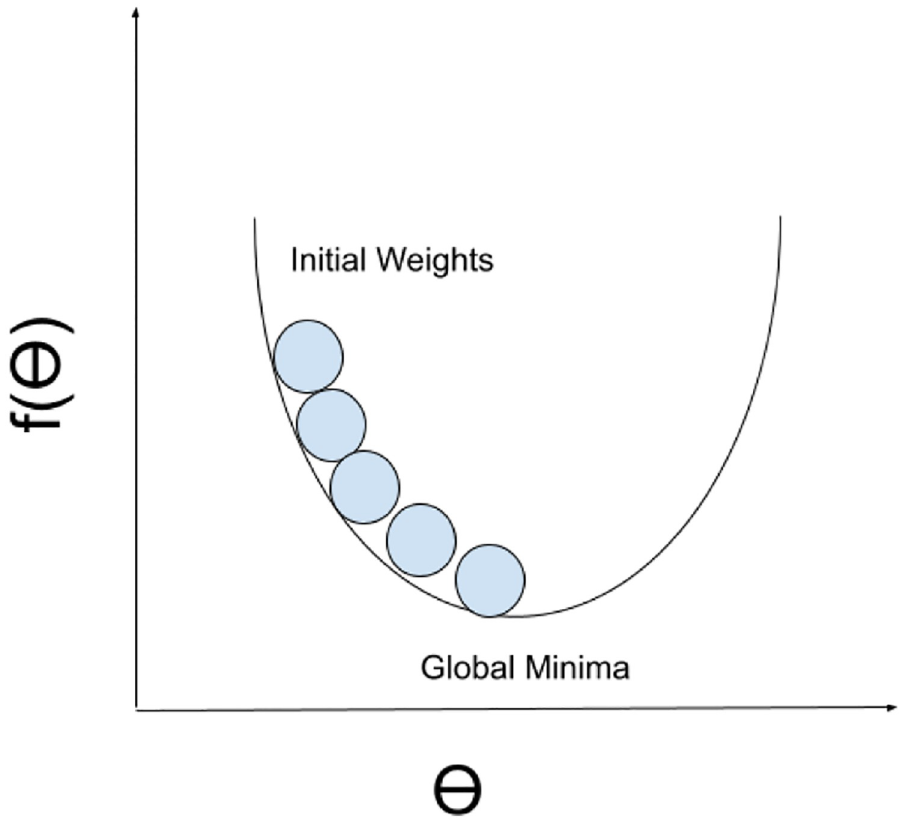
Fig 2. Gradient descent optimization. The figure shows incremental steps on how the algorithm comes to a point of minimum error.